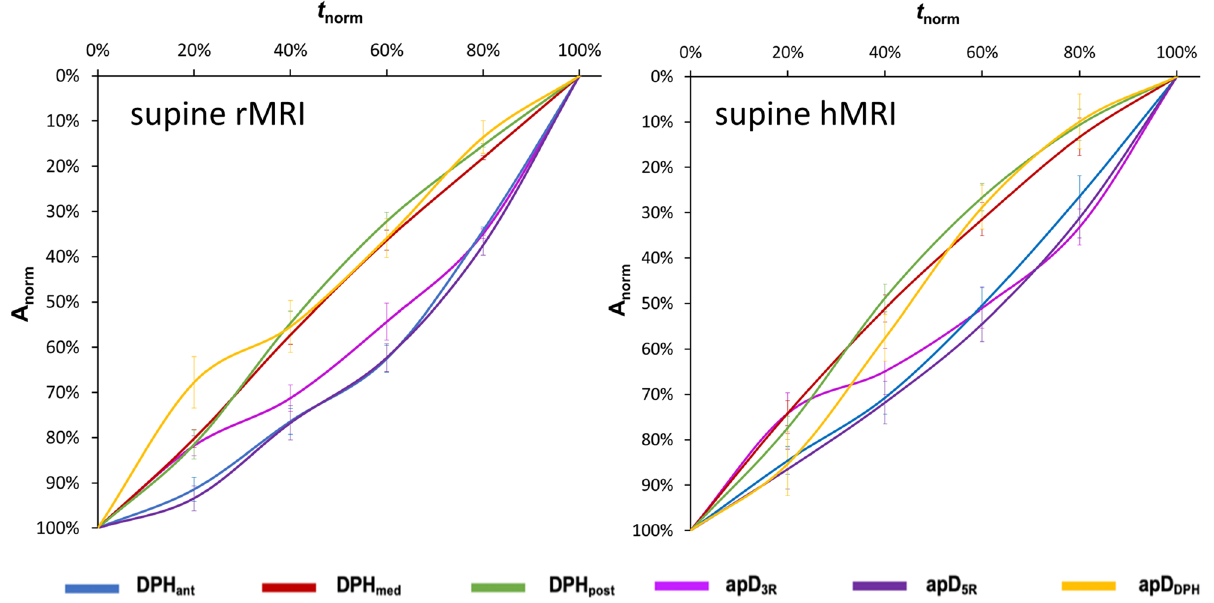
Figure 4. General agreement of normalized motion curves from rotatable MRI (= rMRI) and conventional MRI (hMRI) data in supine position as error detection experiment. Normalized motion curves of 6 measured distance parameters from dynamic MRI acquired in supine body position in hMRI and rMRI in subjects 1–3. Normalized time is displayed on x-axis, mean normalized amplitude with standard deviation on y-axis. Different locations are displayed in different